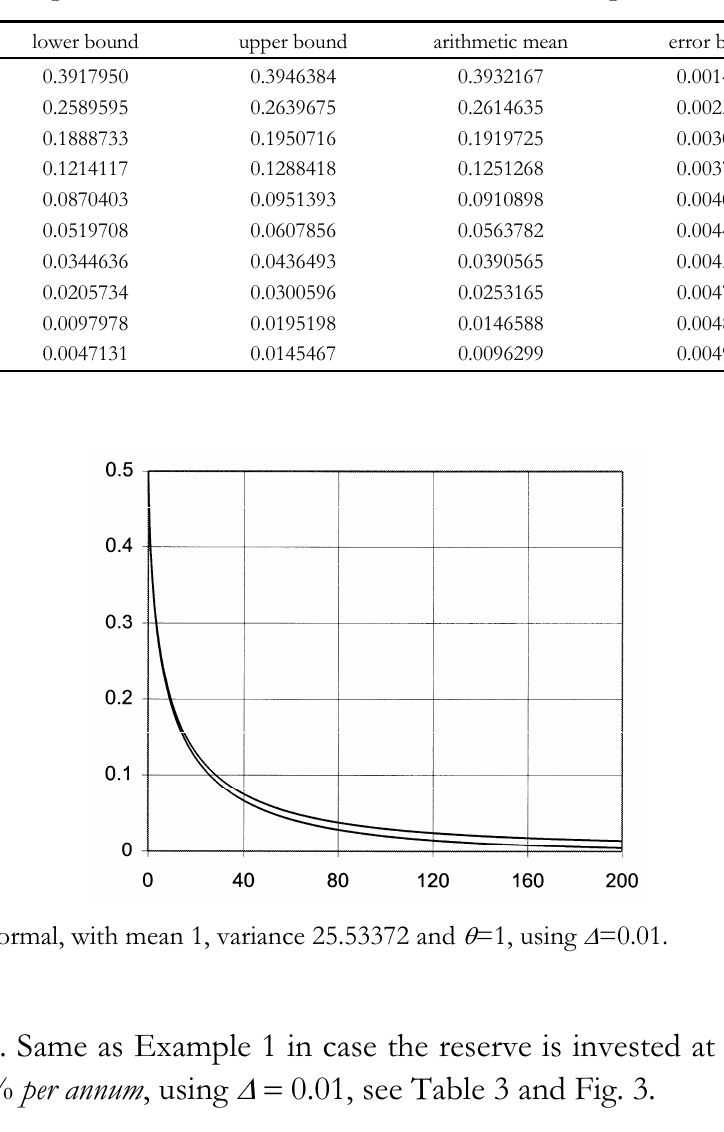
Example 3. Same as Example 1 in case the reserve is invested at a constant in- terest rate 5% per annum , using (cid:39) (cid:32) 0.01, see Table 3 and Fig. 3.